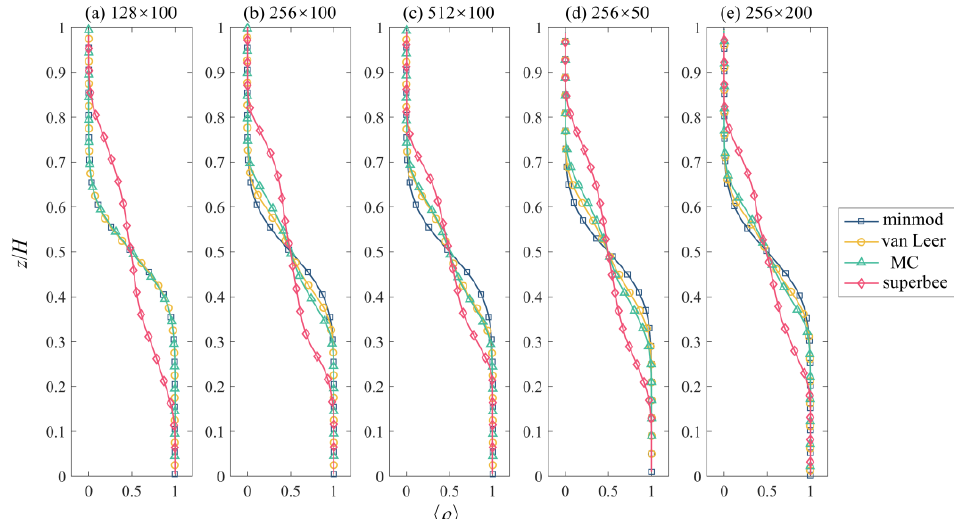
Figure 9. Comparison of horizontal mean density profiles for the shear instability problem with the different slope limiters and different grid resolutions (left to right) at t = 2.4 s. The grid resolutions ( N x × N z ) of the subfigures ( a – e ) are labeled at the top of these subfigures, respectively.